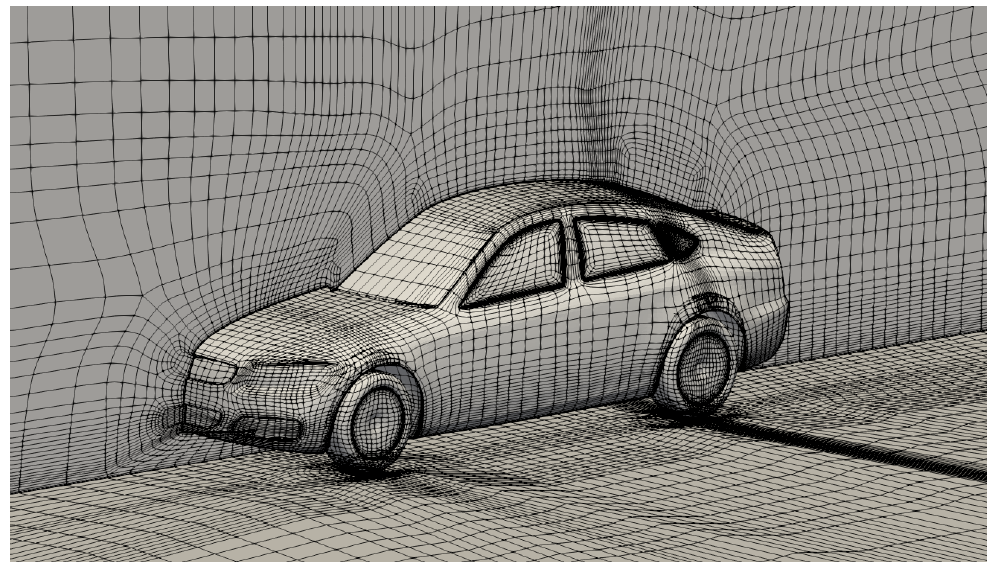
Figure 4. DrivAer model—Mesh with 406304 cubic-edges hexahedral elements.